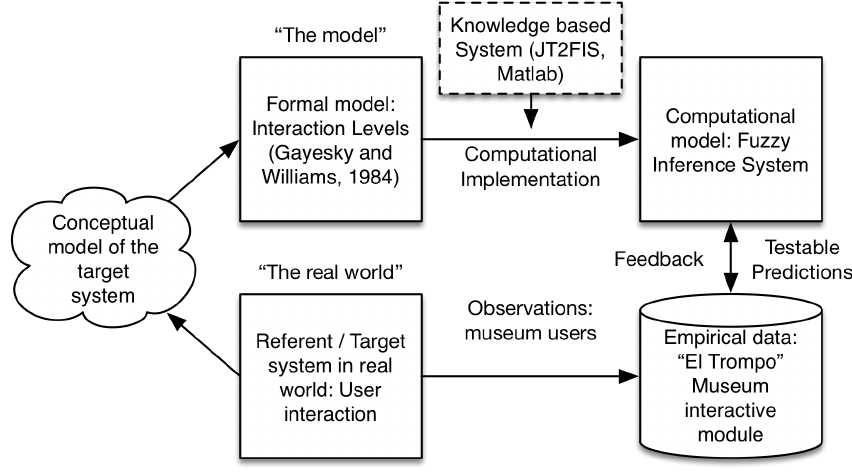
Figure 2. General computational modelling methodology applied to the interactive museum exhibition module case